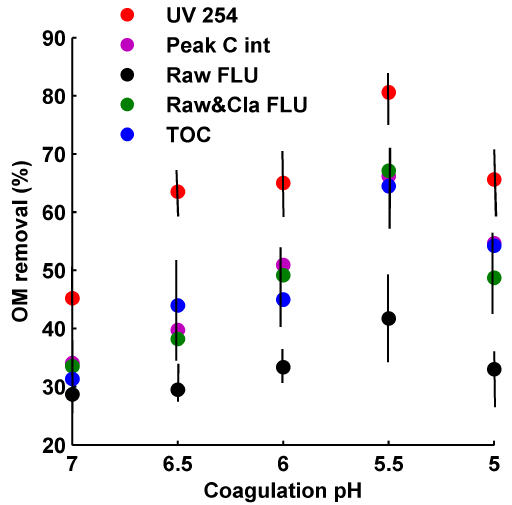
Figure 5. OM removal between raw and clarified water vs. coagu- lation pH (site